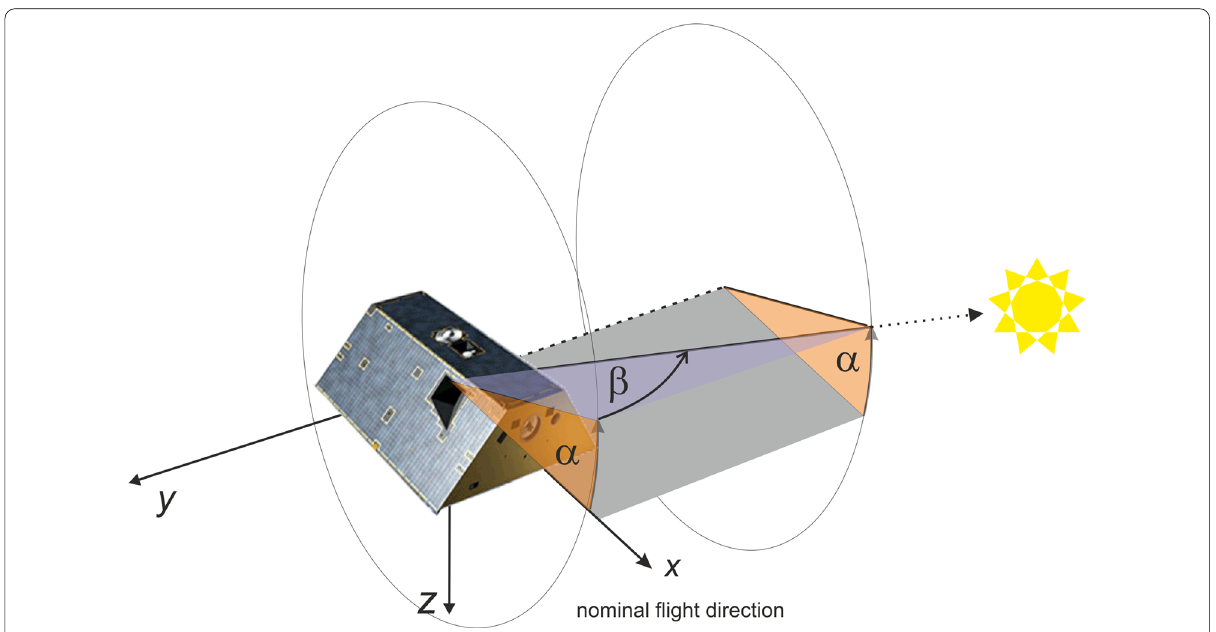
Fig. 4 Illustration of Sun incident angles α and β w.r.t. the